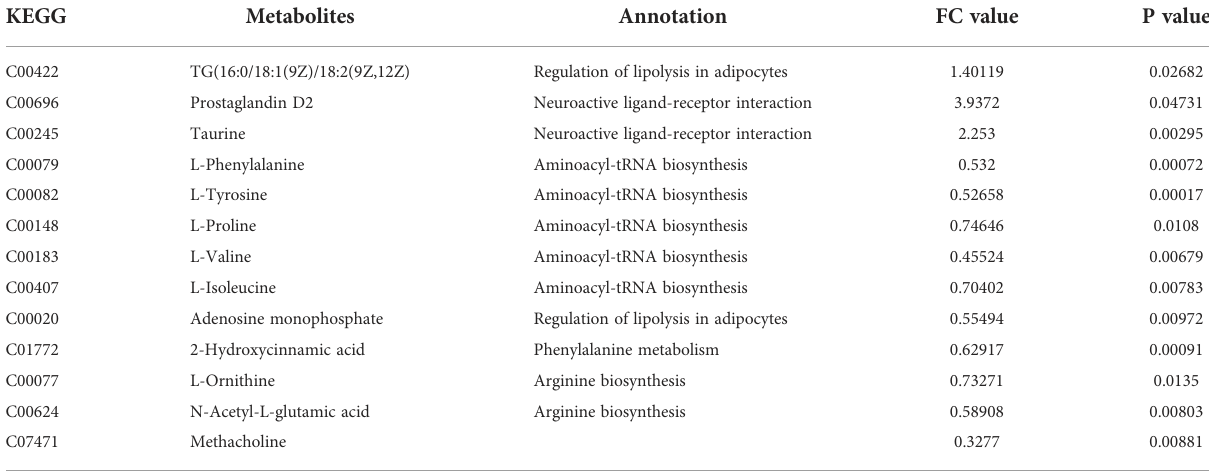
TABLE 2 The DEPs between HFD/Semaglutide(FC value>1, upregulated proteins, FC value<1, downregulated proteins).